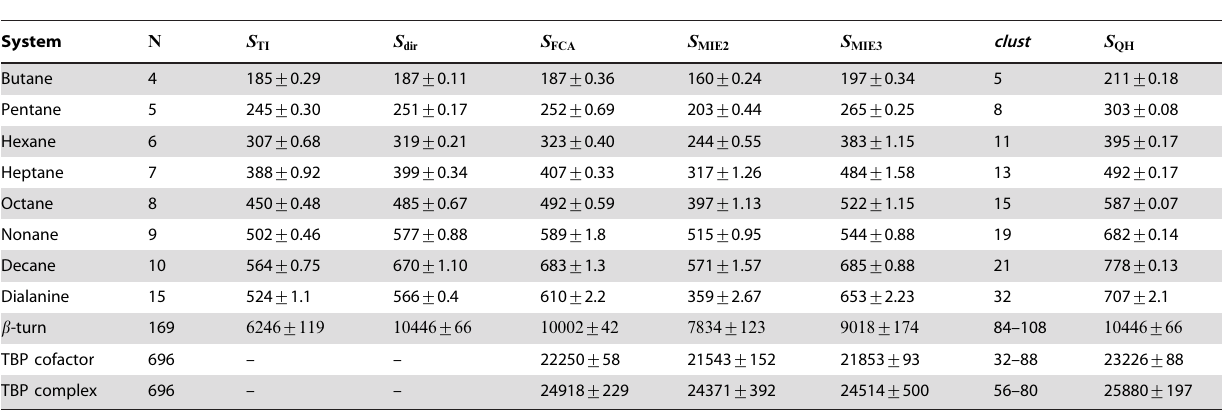
Table 1. Entropy estimates obtained for all